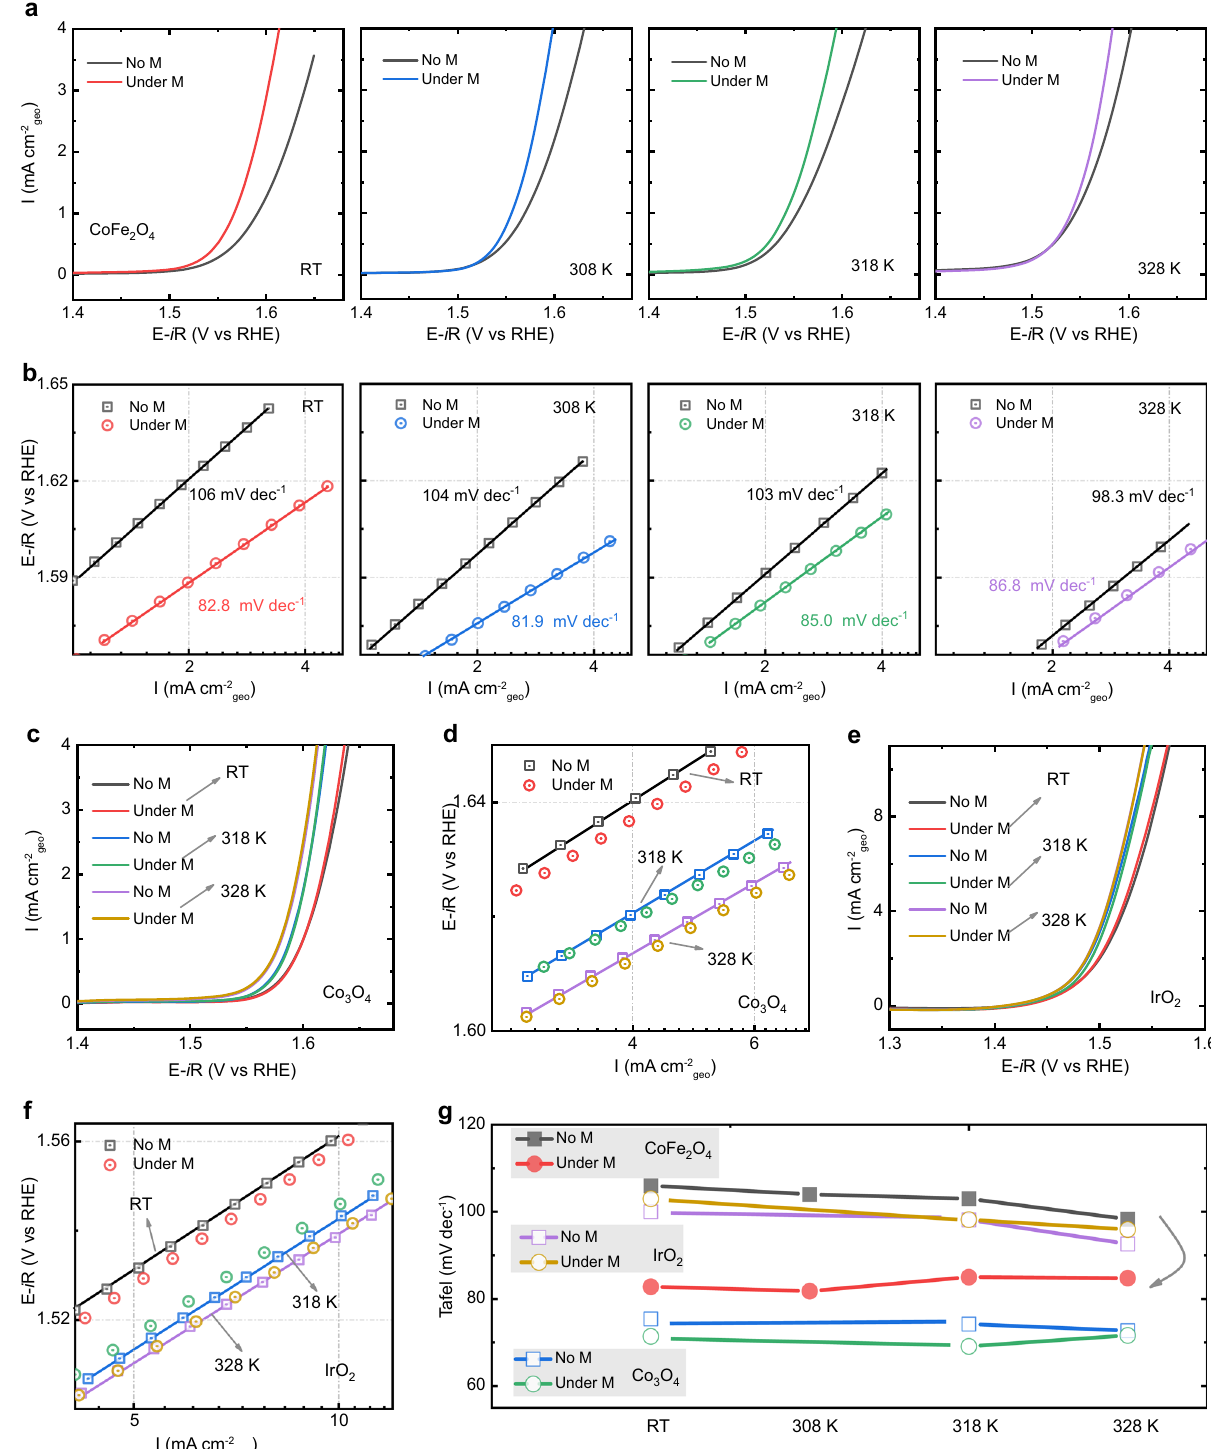
Fig. 3 OER under the different temperature. a LSV curves of CoFe 2 O 4 at a scan rate of 10 mV/s in O 2 -saturated 1 M KOH with and without a constant magnetic fi eld (10,000 Oe) under the different temperatures (room temperature (RT): ~303 K, 308 K, 318 K, and 328 K). The corresponding Tafel plots are shown in b . c LSV curves of Co 3 O 4 with and without a constant magnetic fi eld (10,000 Oe) under the different temperatures (room temperature (RT): ~303 K, 313 K, and 323 K). The corresponding Tafel plots are shown in d . e LSV curves of IrO 2 with and without a constant magnetic fi eld (10,000 Oe) under the different temperatures (room temperature (RT): ~303 K, 313 K, and 323 K). The corresponding Tafel plots are shown in f . Tafel slopes at various temperatures are summarized in g